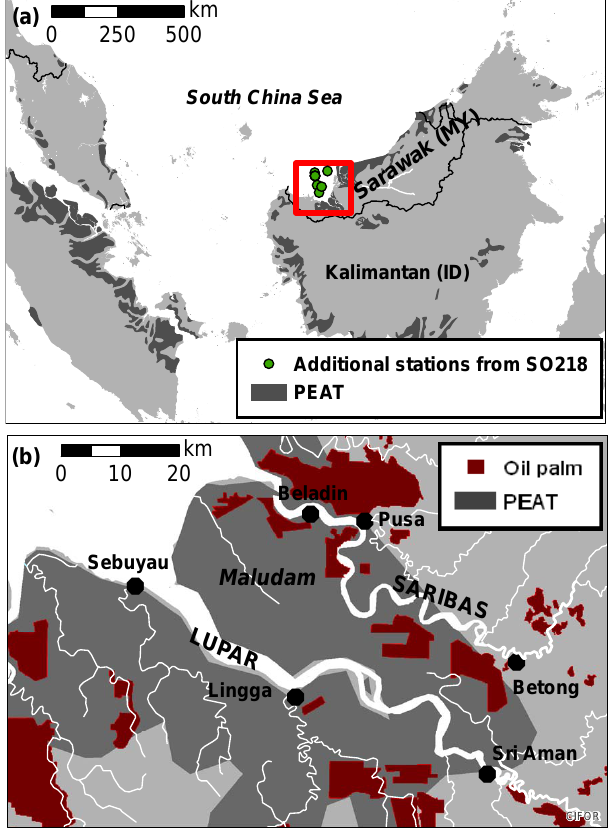
Figure 1. Map of the study area showing (a) the location of Sarawak on the island of Borneo and the cruise track of the R/V Sonne in November 2011 (SO218). (b) Close-up map of the Lupar and Saribas estuaries, enclosing the Maludam Peninsula, showing the major settlements along the rivers and estuaries. Peat areas are indi- cated by the dark grey area; oil palm plantations as of CIFOR (2014) are shown in